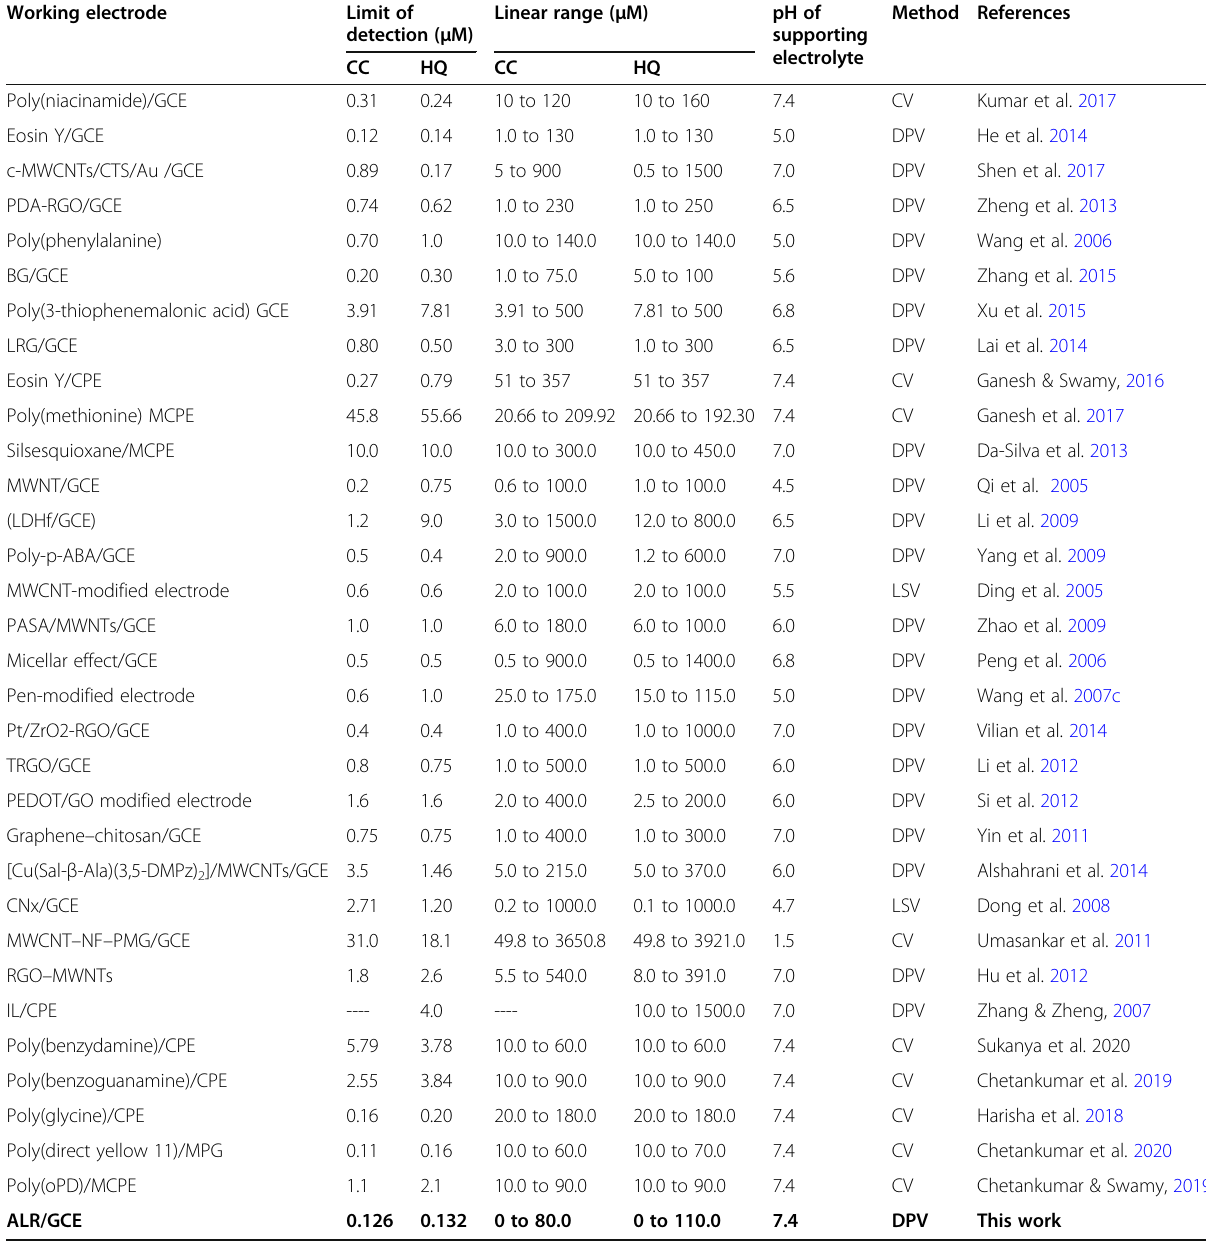
Table 2 Comparison of LOD obtained for CC and HQ at ALR/GCE with other modified electrodes, method and pH of the supporting electrolyte used Working